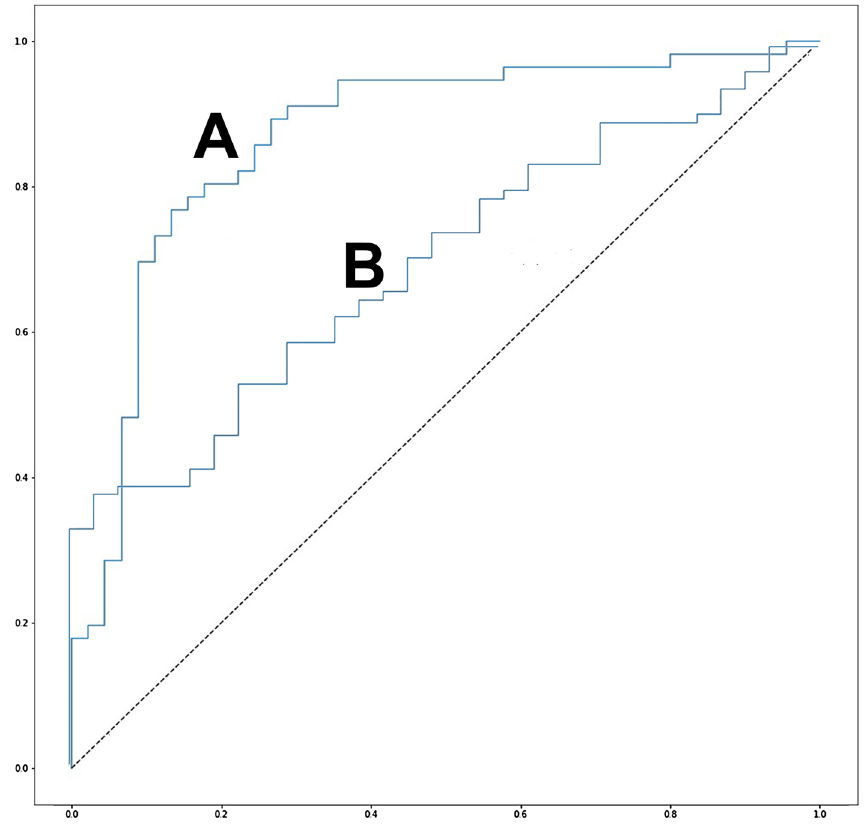
Figure 1. ROC curves of our osteoporosis prediction algorithm. The ROC curve of internal validation with 101 validation datasets is shown in ( A ) with AUC value of 0.867, and the ROC curve of external validation with 117 datasets is shown in ( B ) with AUC value of